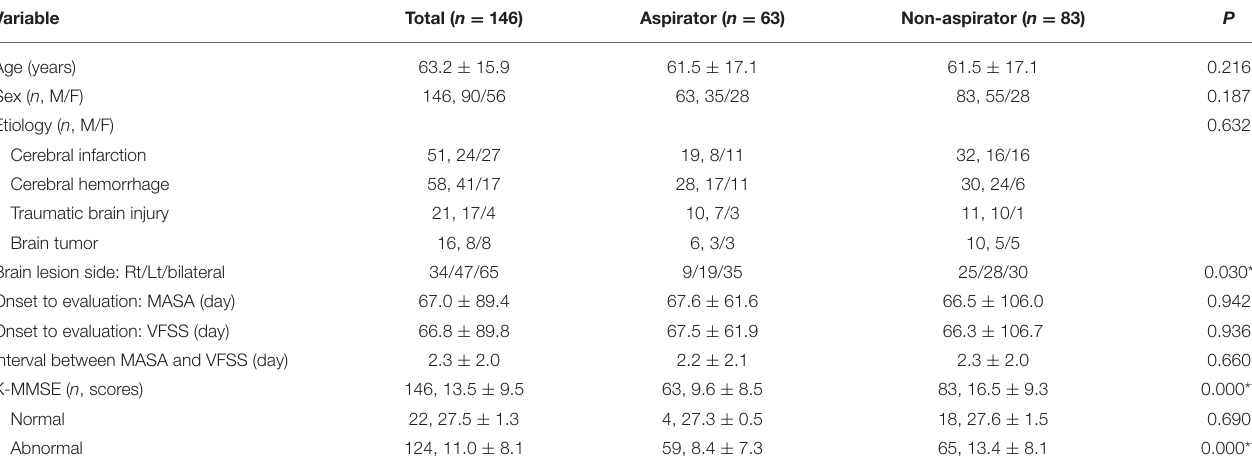
TABLE 1 | Demographics and clinical characteristics of patients ( n = 146).